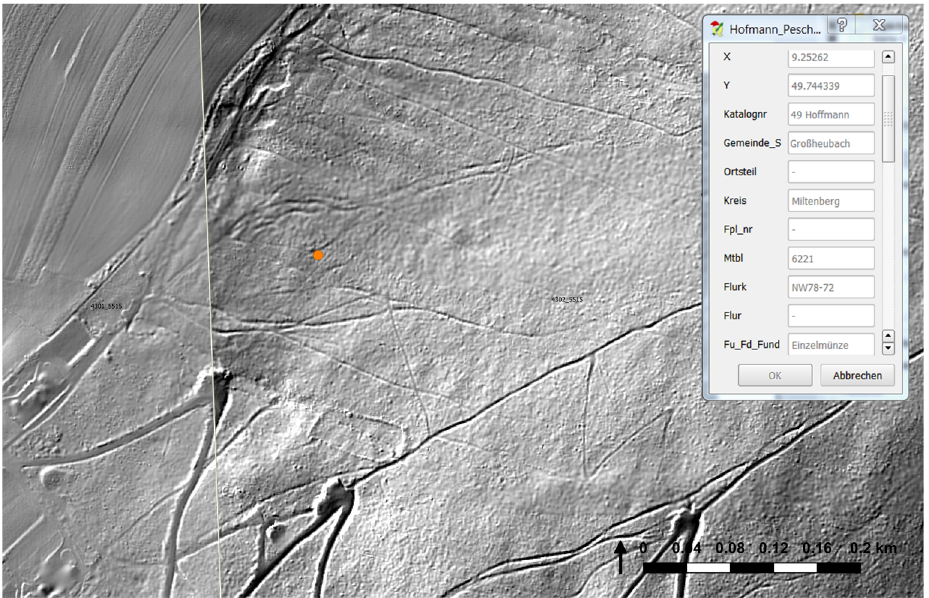
Figure 5. Sunken roads in a multiple pathway system with temporarily used sections running uphill from the flat fields (left) to a forested plateau (right), generally dated from the Iron Age to the High Medieval Period. These and many other archaeo- logical features (such as grave mounds) survived particularly well in forested areas as they prevented plowing. Based on the discovery of a Roman coin from the Late Roman Iron Age (red dot) it is possible to precisely date the corresponding section of path; site data from the GIS-linked database is on the right. Subsequent geoarchaeological field studies should confirm this assertion and examine the multiphase nature of the pathway system in detail. Source: DTM1 from the Bayerisches Landesamt für Vermessung und Geoinformation, GIS